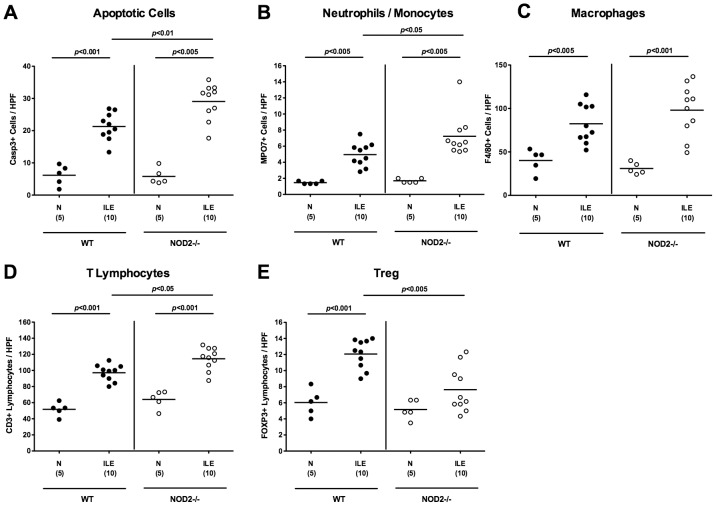
Intestinal immune cell responses following ileitis induction in NOD2 deficient mice.Immune cell responses were assessed microscopically in ileal paraffin sections derived from C57BL/6 wildtype (WT; black circles) and NOD2 deficient (NOD2-/-; white circles) seven days following ileitis induction (ILE) applying in situ immunohistochemistry. The average numbers of ileal (A) apoptotic cells (positive for caspase-3), (B) neutrophilic granulocytes and monocytes (positive for MPO-7), (C) macrophages (positive for F4/80), (D) T-lymphocytes (positive for CD3), and (E) regulatory T-cells (Treg, positive for FOXP3) were determined microscopically in six high power fields (HPF, 400× magnification) per animal. Naive mice served as negative controls (N). Numbers of analyzed mice (in parentheses), means (black bars) and levels of significance (P-values) as compared to the respective groups (determined by Mann-Whitney-U test) are indicated. Data shown are representative for three independent experiments.